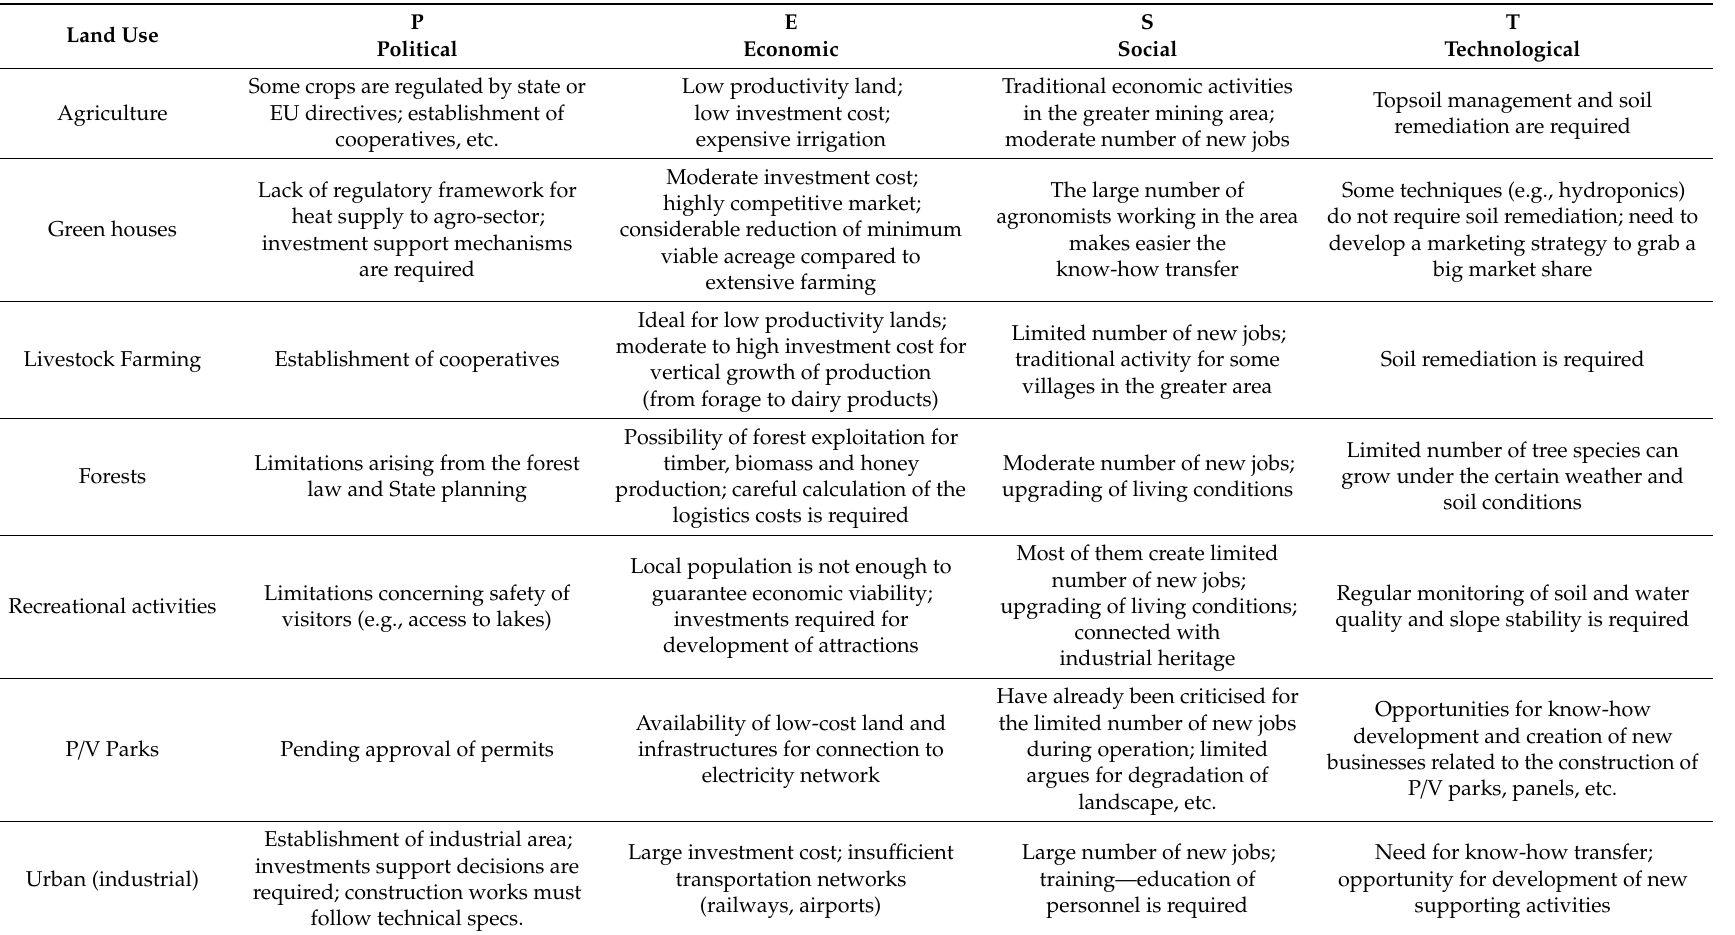
Table 2. PEST analysis of the major macro-environment factors that a ff ect decisions regarding post-mining land uses